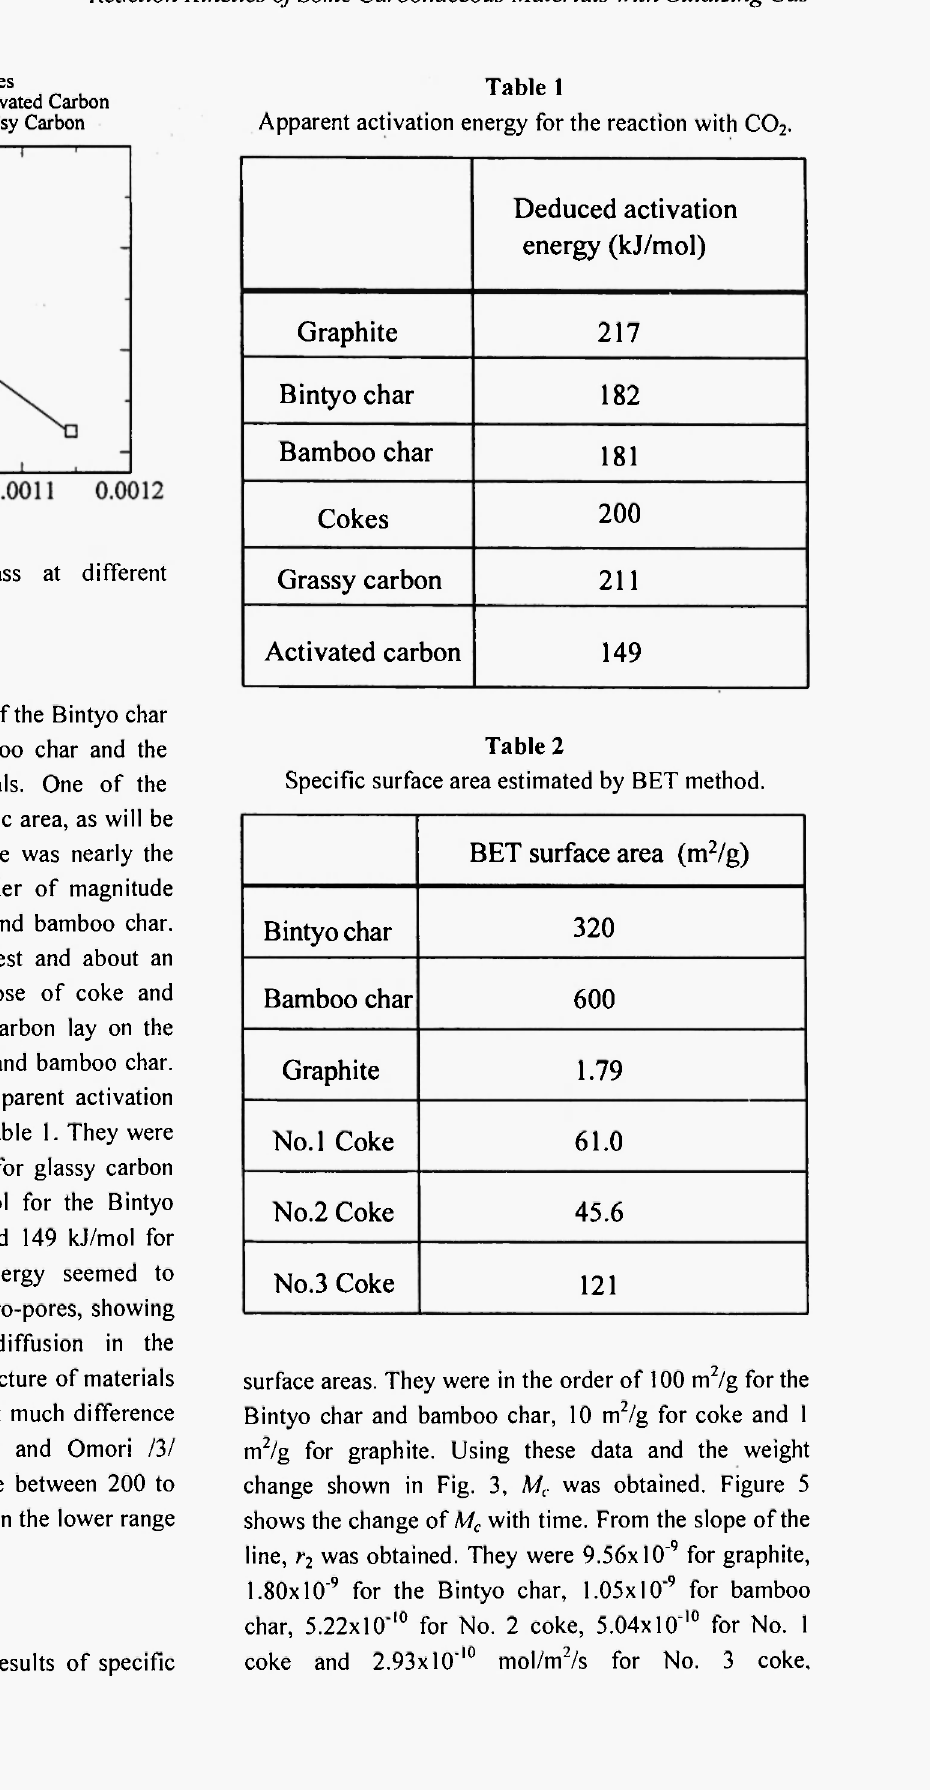
Apparent activation energy for the reaction with C0 2 .